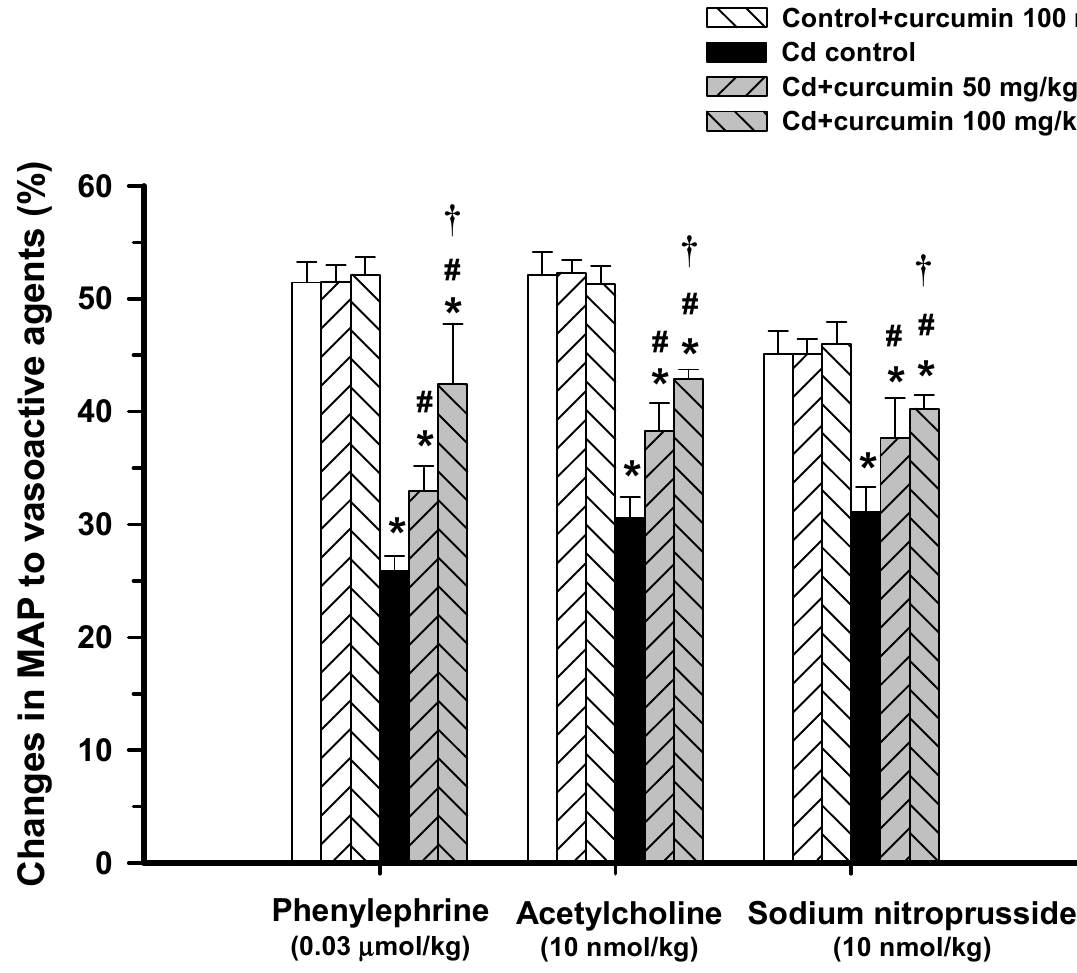
(100 mg/L in 2 control 2